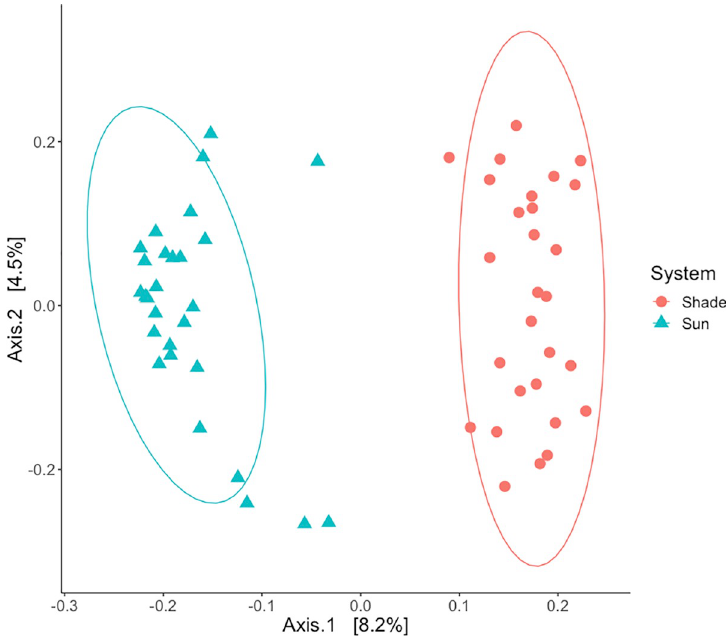
Fig 5. PCoA visualizing Jaccard beta diversity patterns of sun and shade coffee systems. Coffee soil collected from the sun-intensive system had distinct fungal communities from coffee soil collected in the traditional shade system.